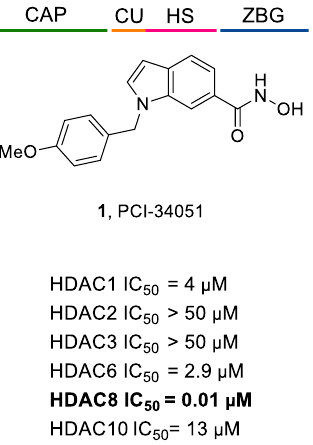
Figure 4. Activity and selectivity profile of PCI-34051 ( 1 ) [19].